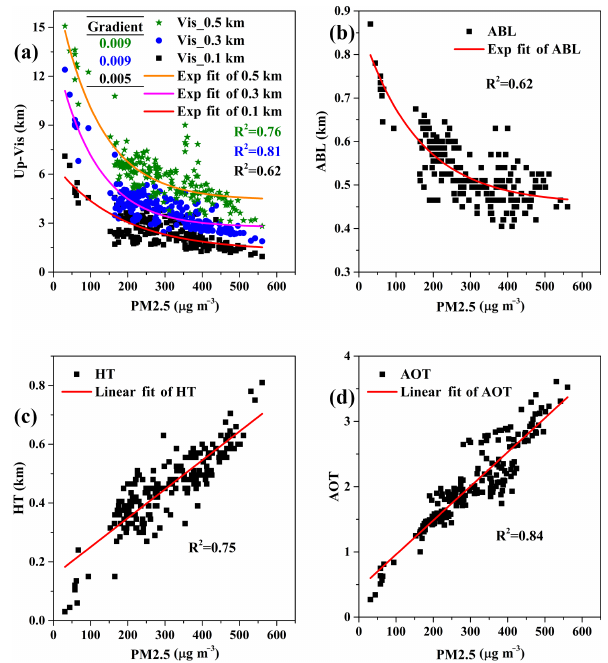
Figure 7. Scatter plot of PM 2 . 5 mass concentration and haze param- eters of Up-Vis, ABL, HT, and AOT in the northwest of downtown Beijing. The inserted table in (a) denotes the statistical gradient of Up-Vis at different altitudes.